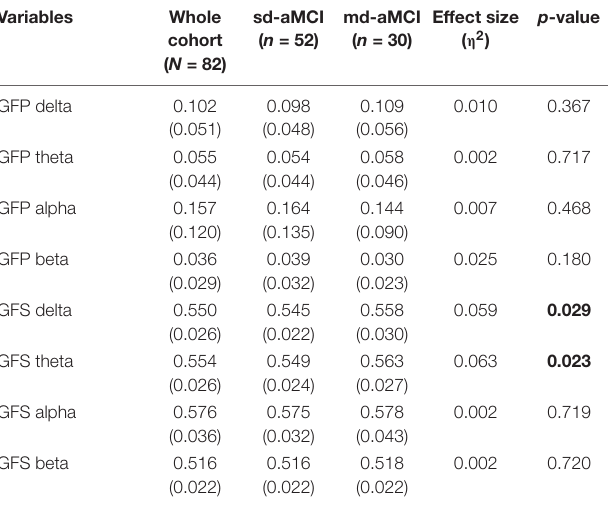
TABLE 5 | qEEG measures of global field power (GFP) and synchronization (GFS) in four conventional frequency bands in the whole MCI cohort and sd-aMCI and md-aMCI